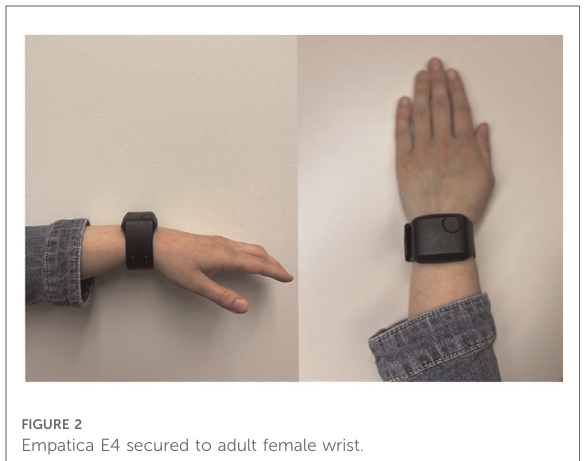
FIGURE 2 Empatica E4 secured to adult female